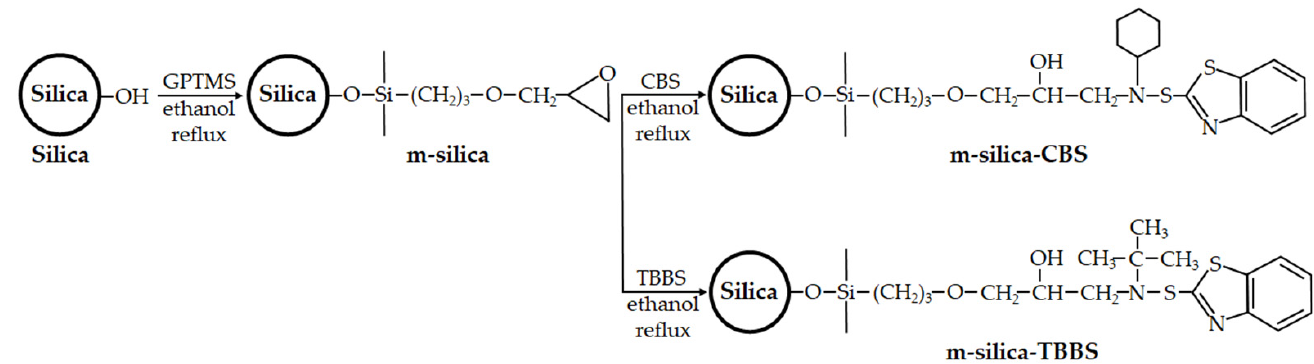
Figure 2. Synthesis of m-silica, m-silica-CBS, and m-silica-TBBS.